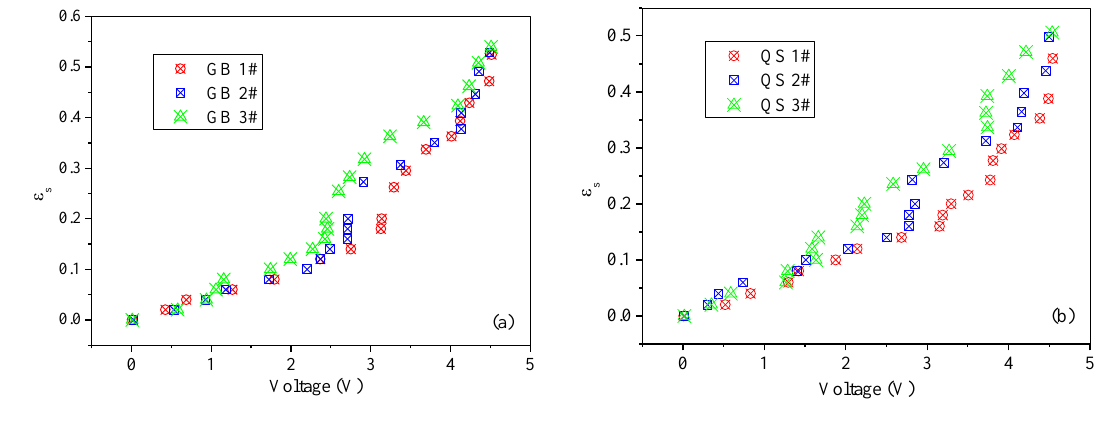
Figure 9. Effect of particle size on the calibration results: ( a ) Glass beads; ( b ) Quartz